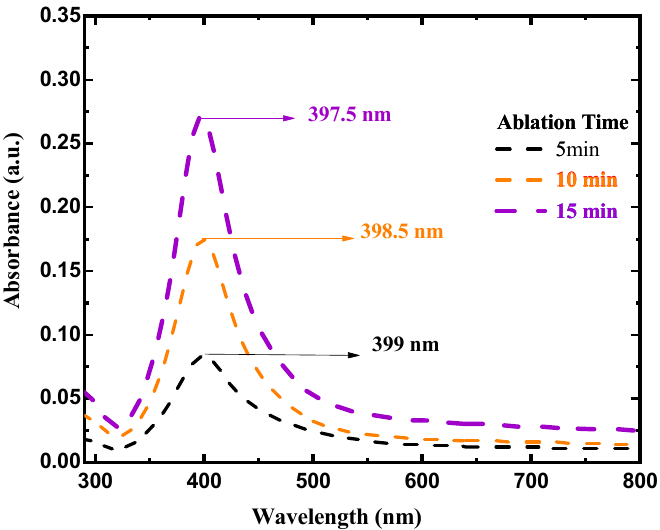
Figure 3. UV–Vis absorbance spectra of AgNP colloids at constant ablation energy of 100 mJ/pulse and at different ablation times.